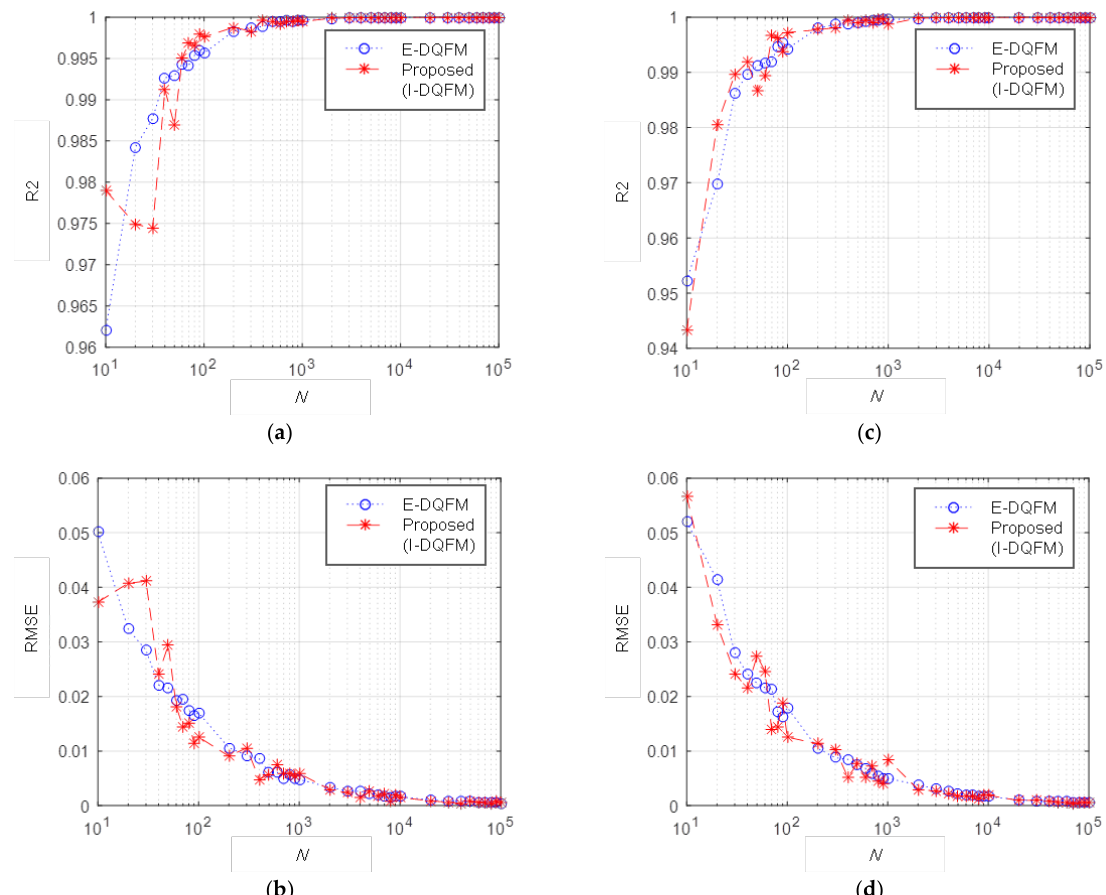
Figure 10. Comparison of multi-hazard system fragility results regarding the example (C1 ∪ C2) ∩ C3 ((3) partially dependent condition): ( a ) E-DQFM; ( b ) proposed (I-DQFM).